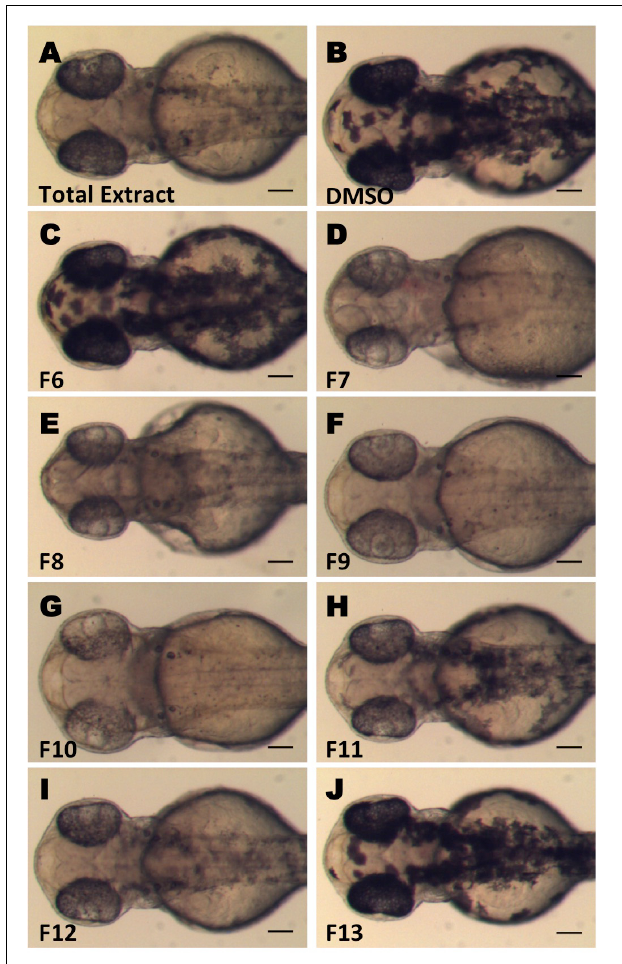
FIGURE 1 | Screening for inhibitors of melanogenesis from Crataegus pycnoloba extracts. Crude extract (A) and fractions (C–J) were tested for anti-pigmentation ability by in vivo zebrafish assay. Synchronized 24 hpf embryos were treated with 0.04 mg/mL of the crude extract and 0.1 mg/mL (CPC-Fr6-8) or 0.01 mg/mL (CPC-Fr9-13) from the different fractions for 24 h. Images were obtained at 48 hpf using a stereomicroscope. Test compounds were dissolved in DMSO. (B) Control treated embryo. Scale bar: 100 µ